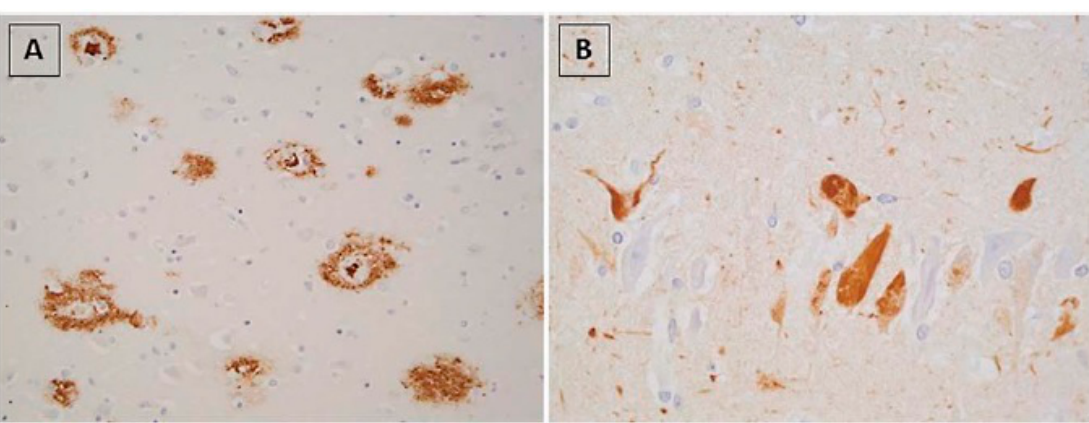
Figure 3. Alzheimer’s disease neuropathology in humans. ( A ) Senile plaques and globose diffuse